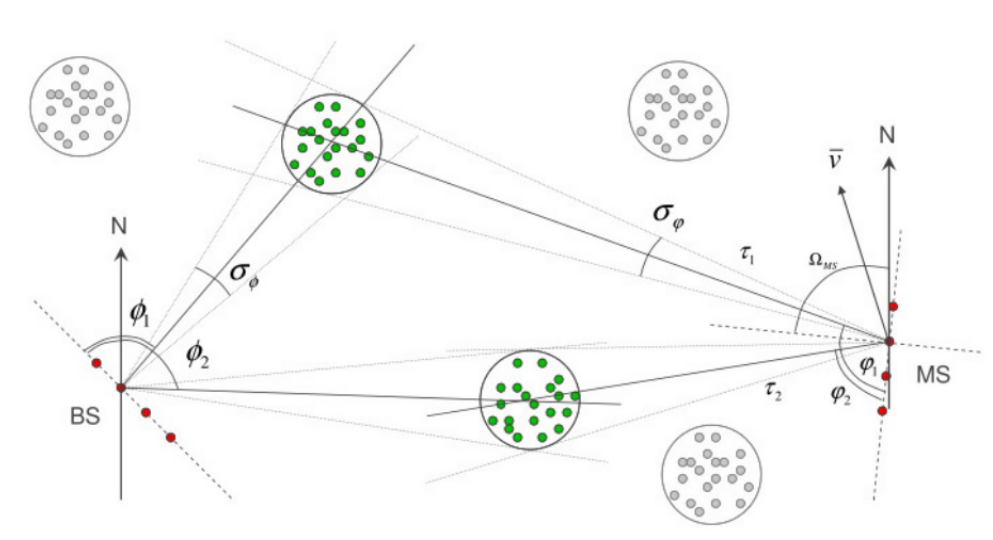
Figure 2. WINNER II D2a channel